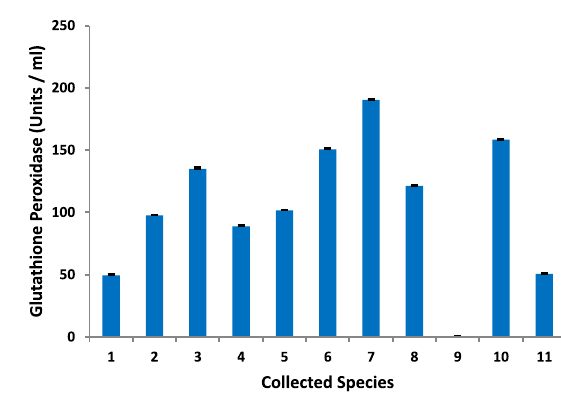
Fig. 5 Glutathione peroxidase activity